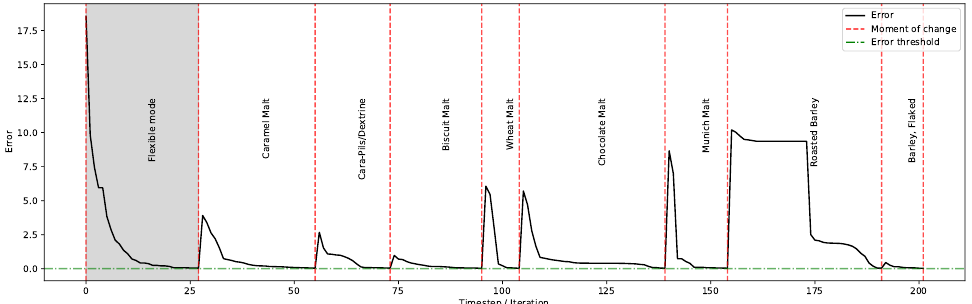
Figure 10. User selection of one ingredient at a time for full